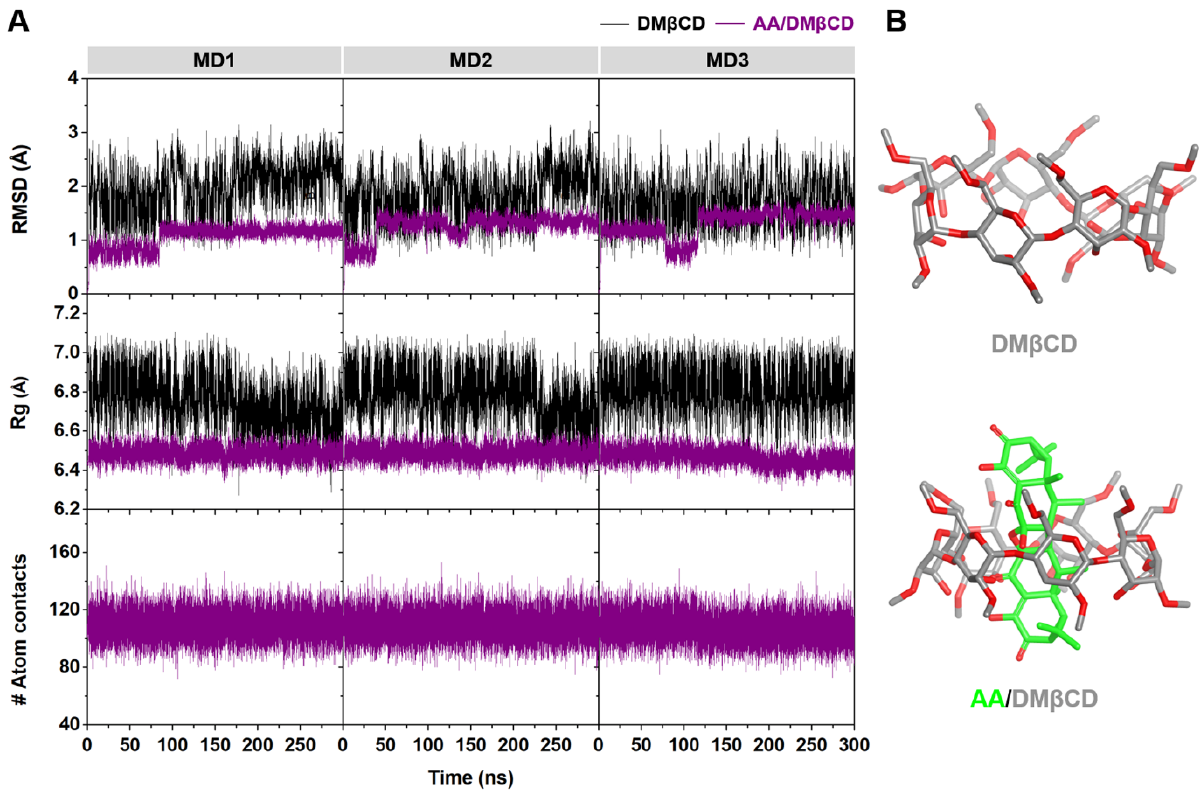
Figure 7. ( A ) Time evolution of RMSD, Rg, and # Atom contacts of DM β CD and AA/DM β CD for three independent simulations (MD1–3). ( B ) Final MD snapshot of DM β CD and AA/DM β CD.